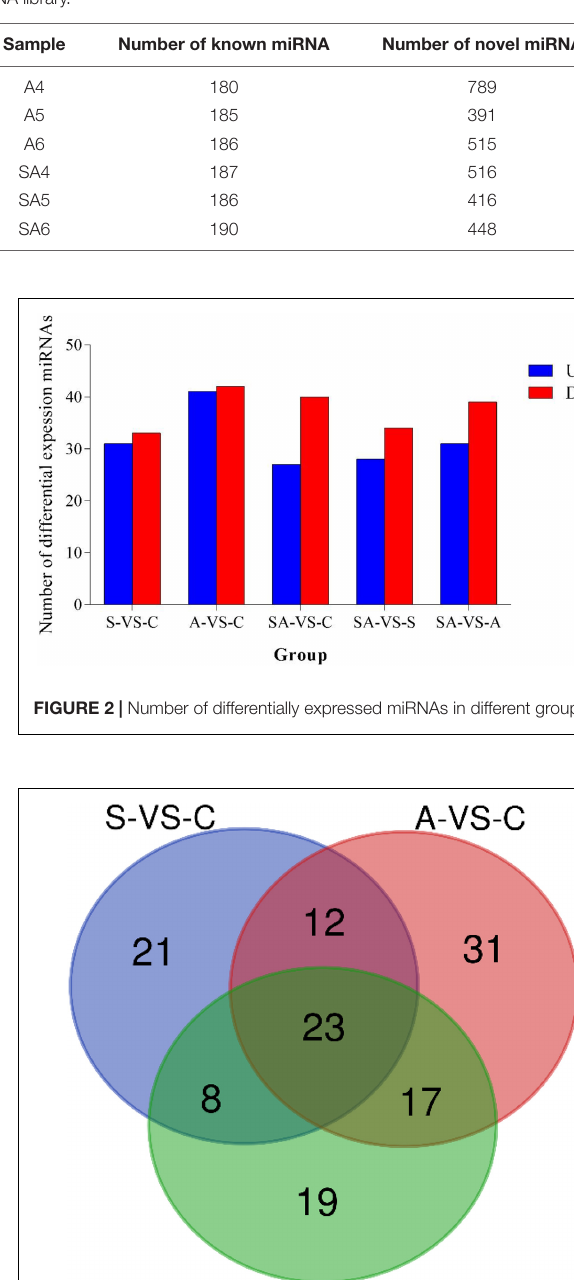
specific. The results of qPCR were compared with the miRNA-Seq analysis results ( Figure 4 ). The results of qPCR were significantly correlated with the RNA-sequencing results with a correlation coefficient of 0.94 ( P < 0.01), indicating the credibility of the miRNA sequencing